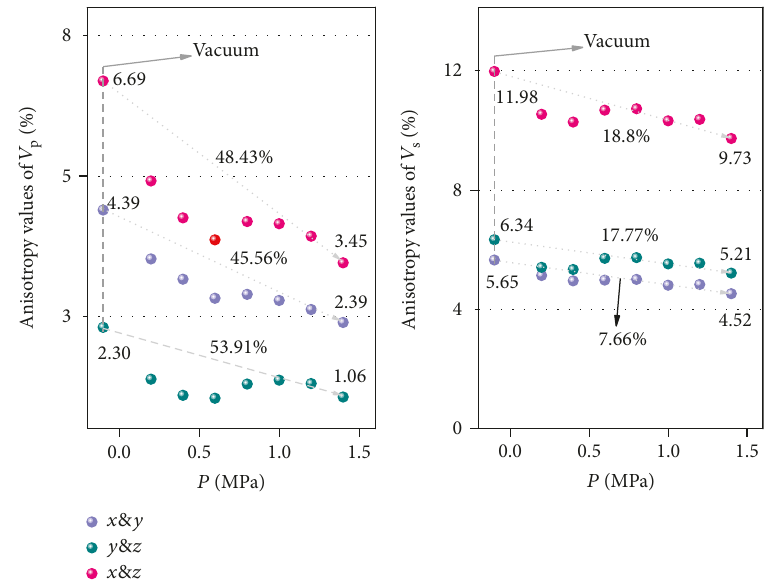
Figure 7: Anisotropy of V